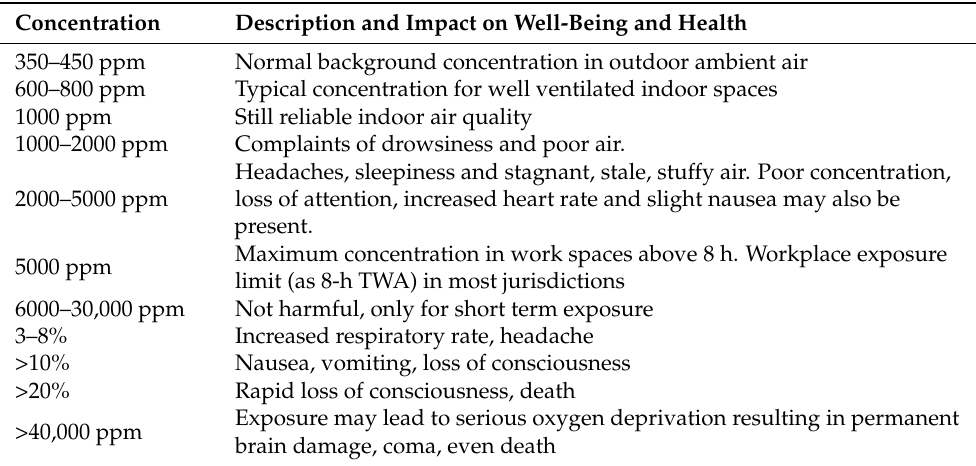
Table 9. CO 2 concentration levels description and its impact on the well-being and health [58,59].